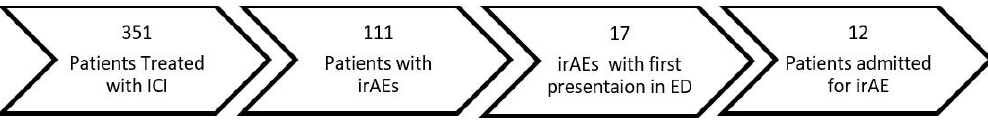
Figure 2. Flow diagram demonstrating the number of patients receiving immune checkpoint inhibitors (ICIs), the number of immune-related adverse events (irAEs), the number of patient with an irAE first diagnosed in the ED and the number of patients admitted as a result.